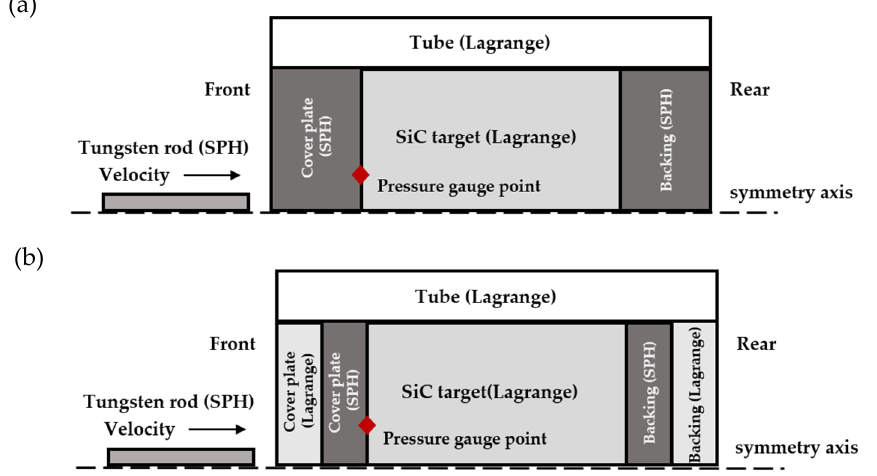
Figure 2. 2D axisymmetric model for the rod and the target, showing part of the numerical model. The pressure gauge point is set on the SiC target surface. ( a ) Free cover plate. ( b ) Fixed cover plate.